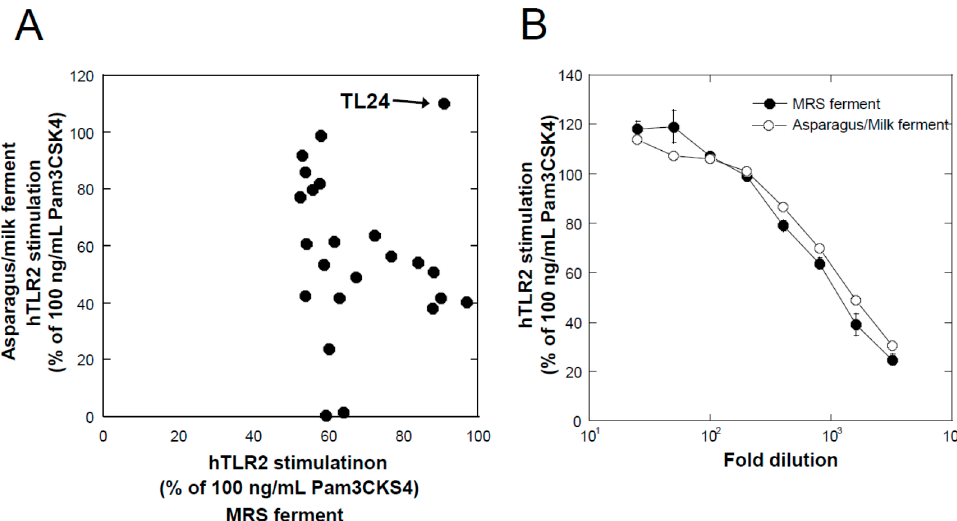
Figure 2. Relationship between two different culture media based on their TLR2-stimulating activity. ( A ) The TLR2-stimulating activities of the ferments obtained from two different culture media using the 23 strains described in Figure 1B were plotted based. Abscissa and ordinate represent 400-fold dilutions of MRS ferments and 25-fold dilutions of asparagus/milk ferments, respectively. The strain with the highest activity in both ferments is indicated by an arrow with its name (TL24). ( B ) Dose-dependent curves of MRS and asparagus/milk ferments for TL24 (n = 2; mean with S.D.).